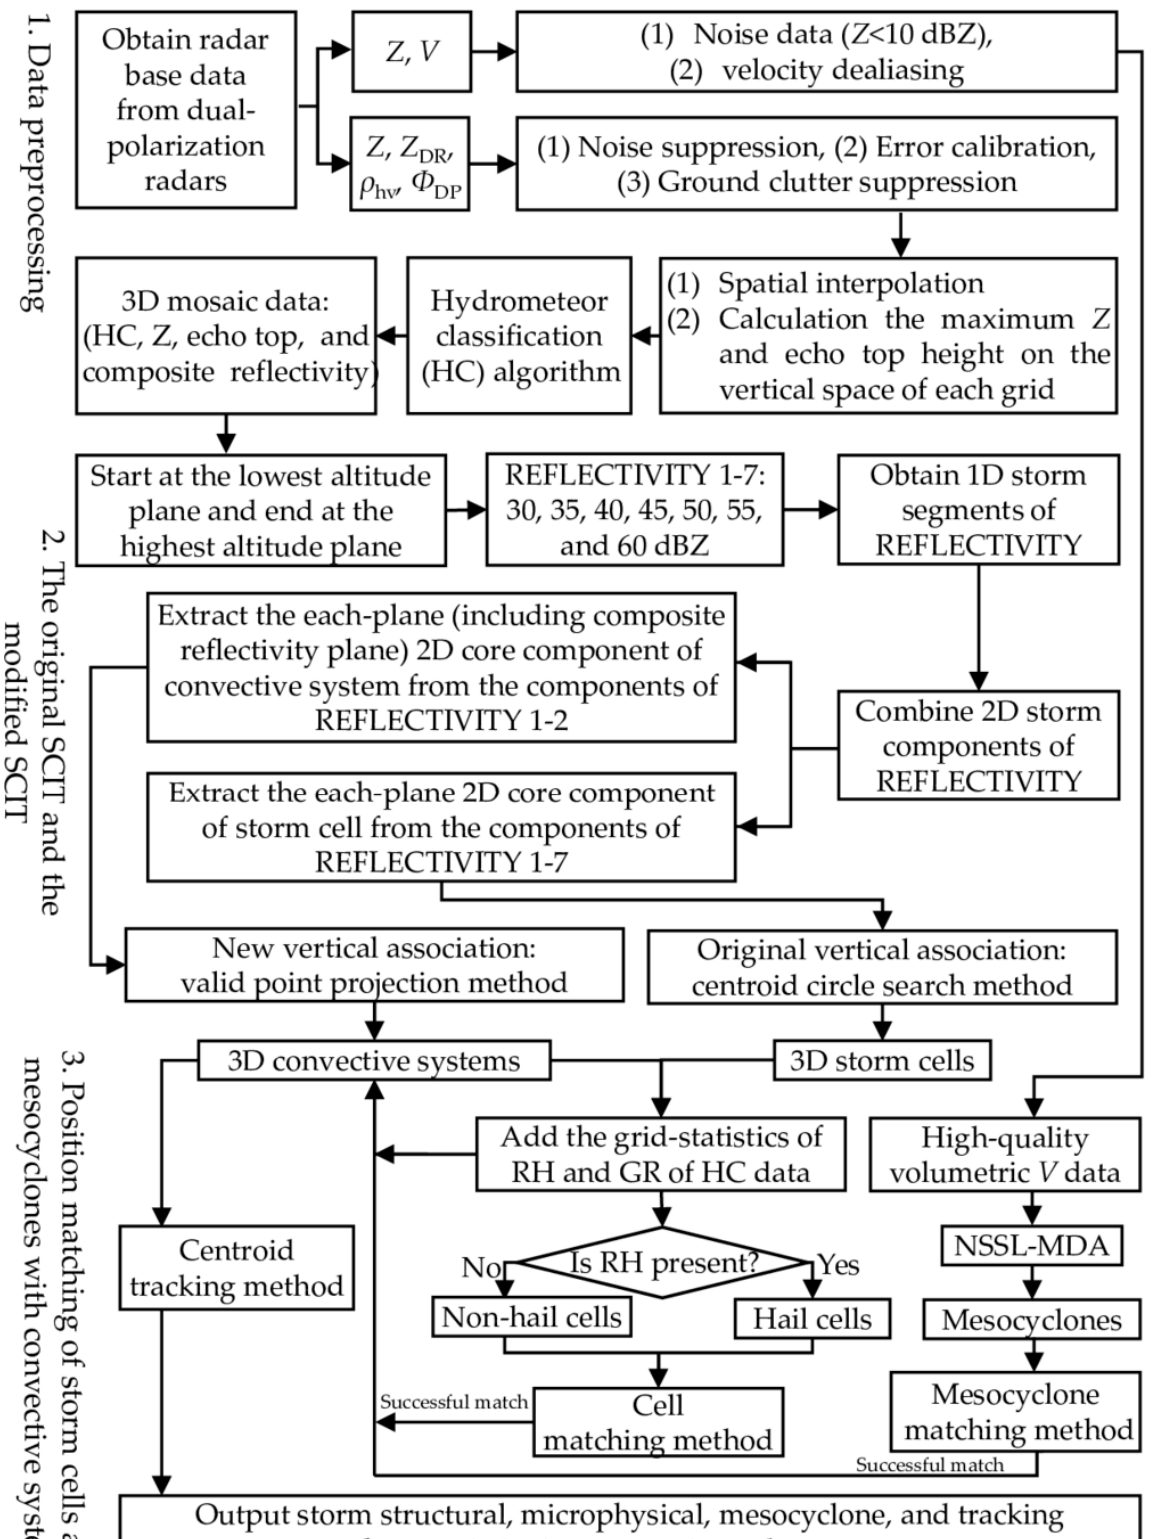
Figure 3. Flowchart describing the Integrated Convective Characteristic Extraction (ICCE) algo- rithm.